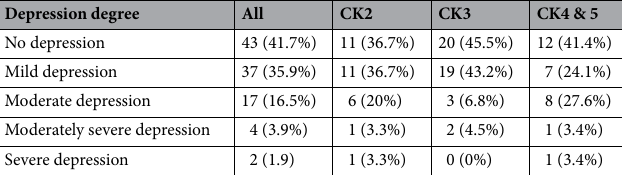
Table 2. Degree of depression according to CKD